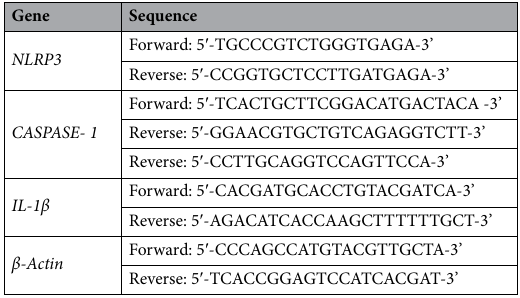
Table 1. Primers used for real-time